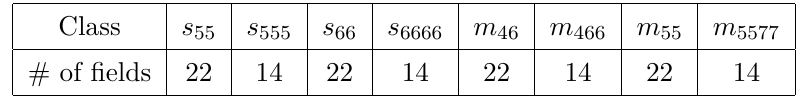
Table 1 . The number of scalar fields for each solution class where new solutions have been found in [15].